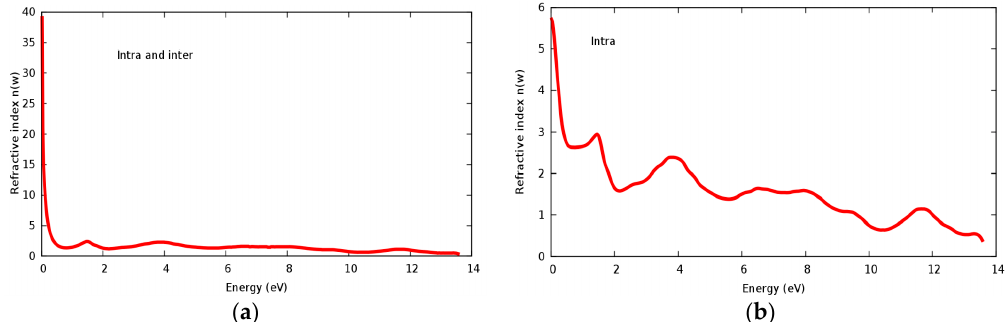
Figure 11. ( a ) Refractive index n ( ω ) within inter and intra; ( b ) Refractive index n ( ω ) within intra for SrRhO 3 compound.